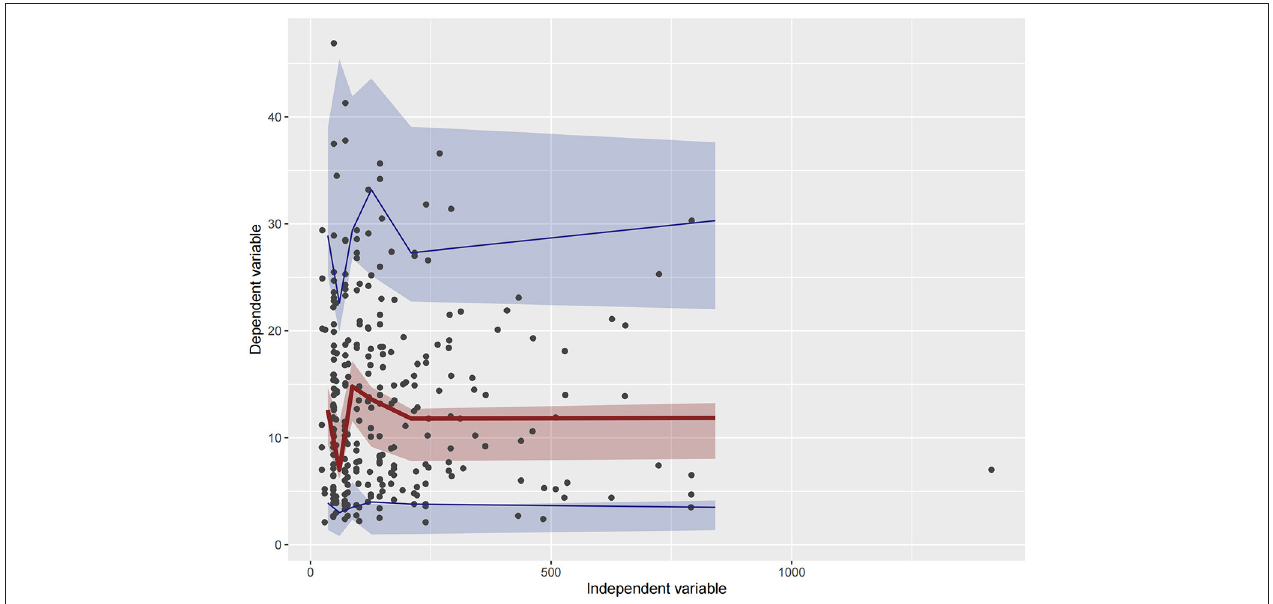
FIGURE 6 | Visual predictive check (VPC) of Model 3. Circles represent observations. The red solid lines represent the median of simulated concentrations, and the blue solid lines represent the 90% PI (5 and 95%) of the predictive vancomycin concentrations. The shaded areas represent the 95% CI for each line.